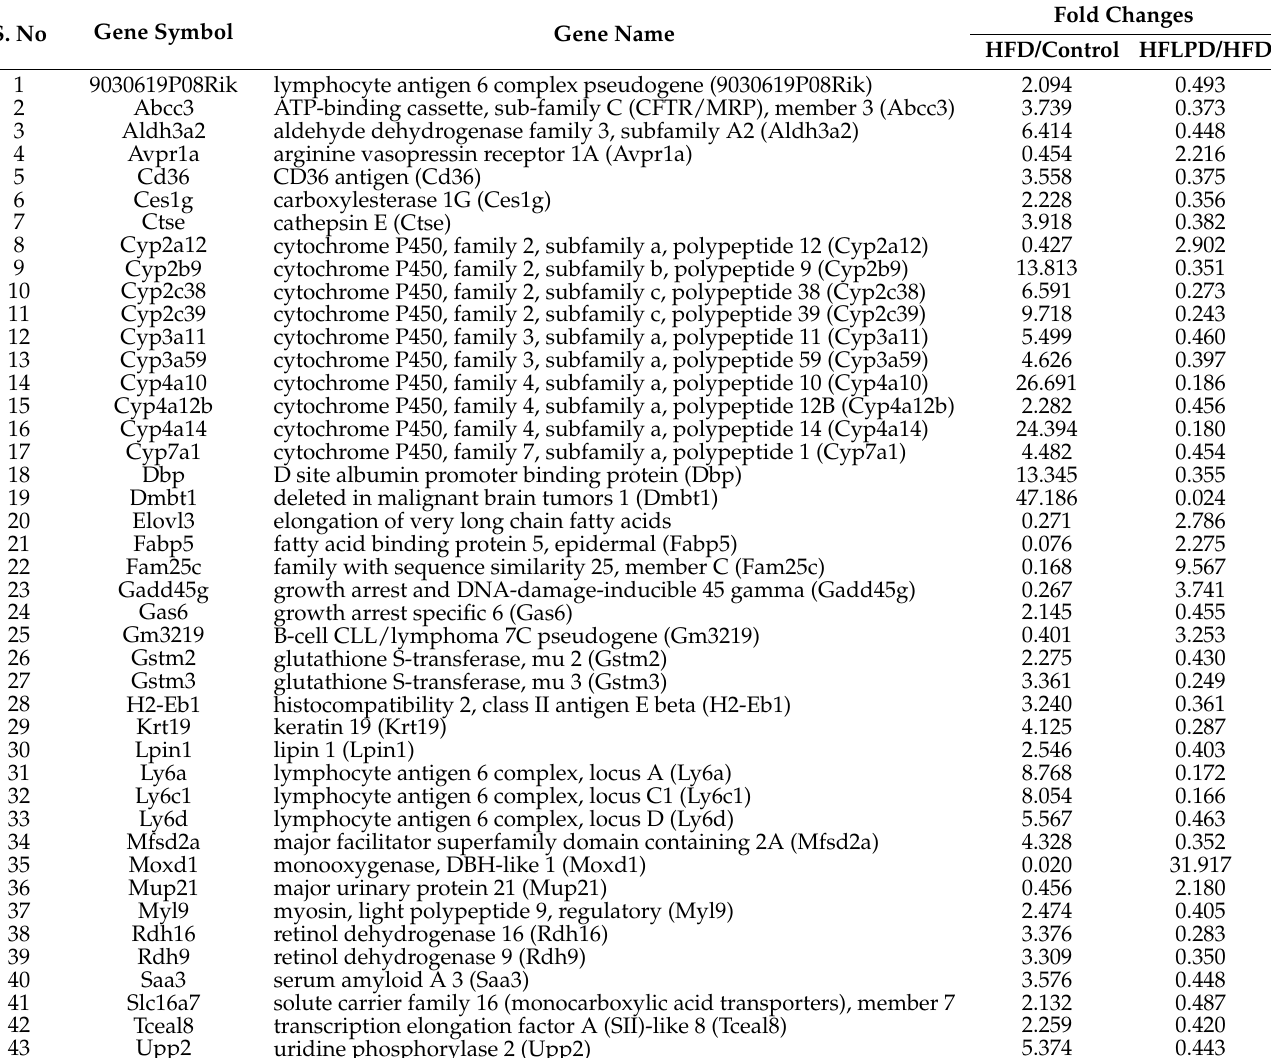
Table 1. Contraregulation of DEGs in the liver of HFD- and HFLPD-fed